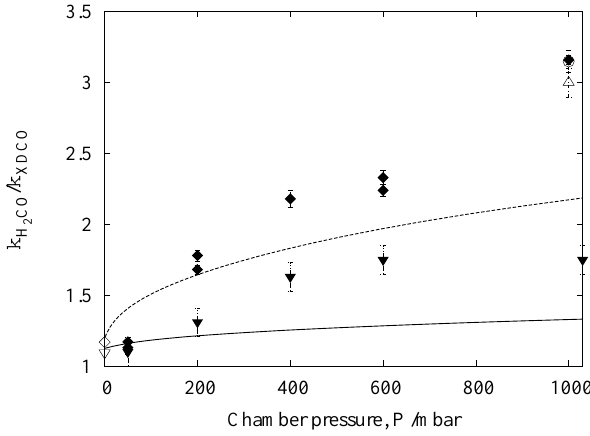
Fig. 4. Relative dissociation rate of formaldehyde k( H 2 CO )/k( XDCO ) ( X = H or D ) as a function of pressure. The diamonds are the same data as presented in Table 2. Closed triangles represent the corresponding values for the HDCO iso- topologue, from Nilsson et al. (2010). Open symbols are previous determinations of k( H 2 CO )/k( D 2 CO ) from Feilberg et al. (2005b, 2007a), triangle, and Nilsson et al. (2009a), circle. Lines represent the calculated isotope